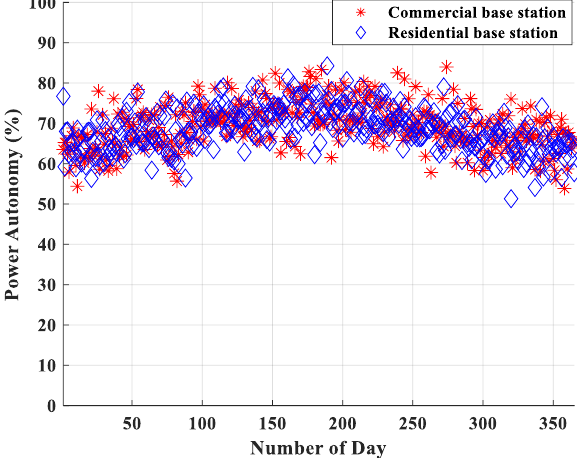
Figure 17. Power autonomy factor for Boujdour throughout the year.